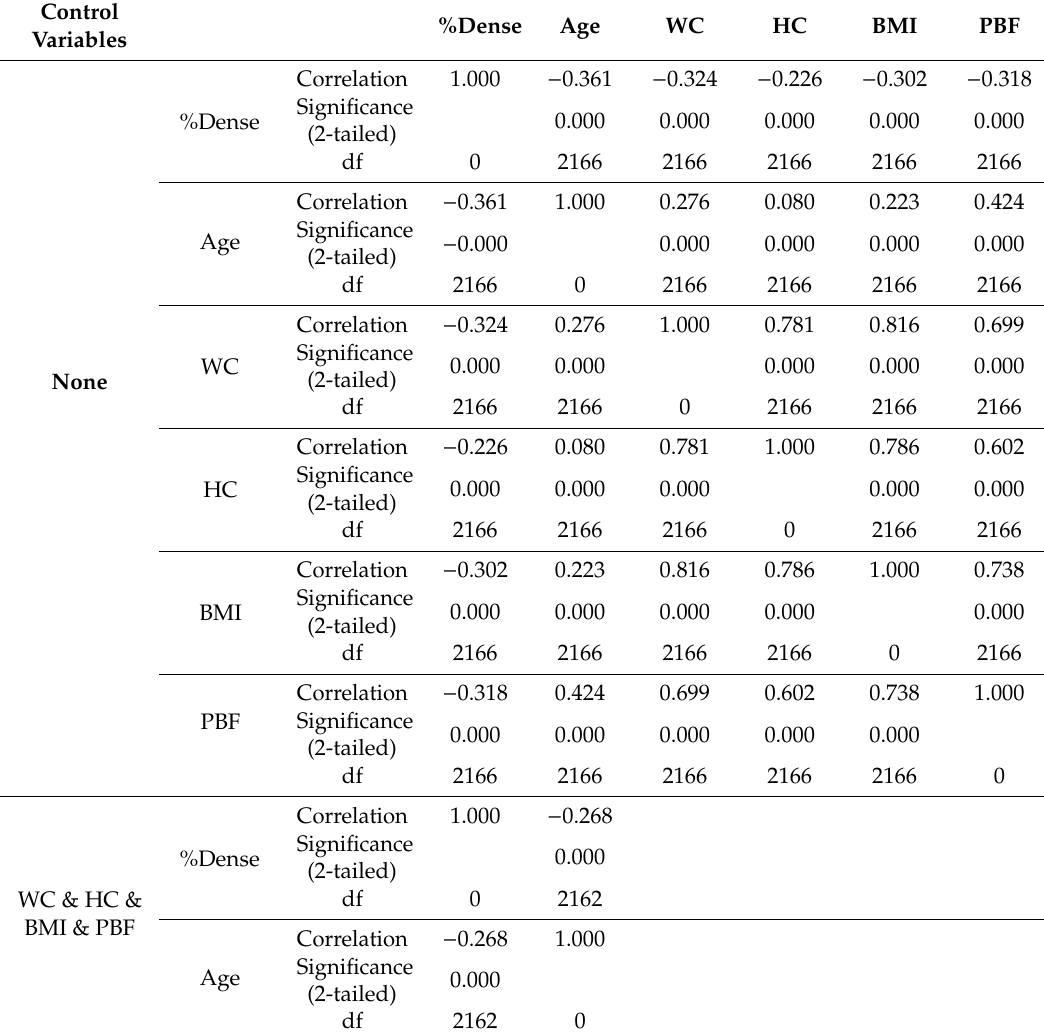
Table 3. Correlation coe ffi cients and partial correlation coe ffi cients between breast density, age, and physical